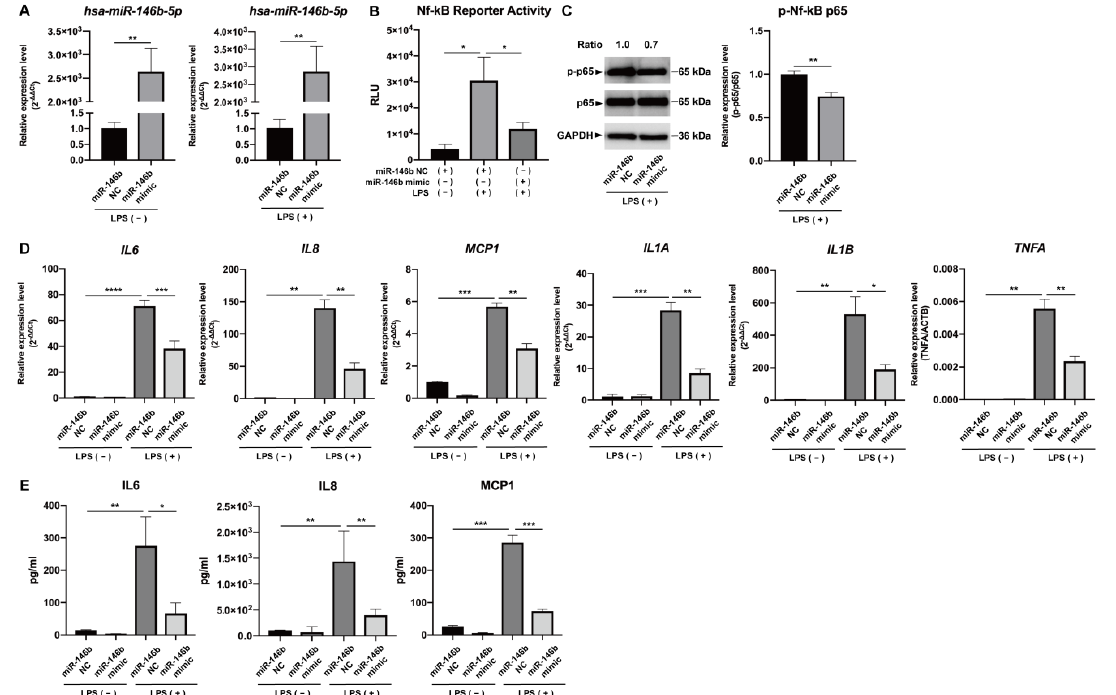
Figure 3. hsa-miR-146b-5p mimic down-regulates the activated NF-κB signaling and up-regulates expression of proinflammatory cytokines in LPS-stimulated hDPCs. ( A ) Transfection of hsa-miR- 146b-5p mimic induced up-regulation of hsa-miR-146b-5p in hDPCs with or without LPS stimulation (mean ± SD, n = 4). ( B ) hsa-miR-146b-5p mimic significantly down-regulated the promoted NF- κB reporter activity in hDPCs under 2 h LPS stimulation (mean ± SD, n = 4). ( C ) hsa-miR-146b-5p mimic significantly down-regulated the promoted phosphorylation of NF-κB p65 expression in hDPCs under 2 h LPS stimulation (mean ± SD, n = 4). ( D ) hsa-miR-146b-5p mimic significantly down-regulated the promoted mRNA expression of IL6 , IL8 , MCP1 , IL1A , IL1B , and TNFA in hDPCs under 2 h LPS stimulation (mean ± SD, n = 4). ( E ) hsa-miR-146b-5p mimic significantly down-regu- lated the promoted protein expression of IL6, IL8, and MCP1 in hDPCs under 2 h LPS stimulation (mean ± SD, n = 3). * p < 0.05, ** p < 0.01, *** p < 0.001, and **** p < 0.0001. LPS: lipopolysaccharide; hDPCs: human dental pulp cells; miR-146b NC: miRNA mimic Negative Control #1; miR-146b mimic: miRNA mimic for hsa-miR-146b-5p; RLU: relative light unit. 2.4. miR-146b-5p Targeted TRAF6, IRAK1, and RELA Tumor necrosis factor receptor-associated factor 6 (TRAF6), interleukin-1 receptor- associated kinase 1 (IRAK1), and REL-associated protein (RELA/NF-κB p65) are essential mediators of NF-κB signaling and are the predicted target genes of miR-146b-5p (Tar- getScanHuman). Over-expression of hsa-miR-146b-5p significantly down-regulated mRNA and protein expression of TRAF6, IRAK1, and RELA in LPS-stimulated hDPCs ( p < 0.05 to 0.001, Figure 4A,B,D,E,G,H). Similar down-regulated expression of TRAF6, IRAK1, and RELA in LPS-stimulated hDPCs was confirmed by immunocytological eval- uation (Figure 4C,F,I). In addition, mRNA and protein expression of TRAF6, IRAK1, and RELA was independent of the presence of LPS ( p > 0.05, Figures 4A,B,D,E,G,H and S2). Furthermore, over-expression of hsa-miR-146b-5p significantly down-regulated the lucif- erase activity in hDPCs transfected with a reporter vector containing hsa-miR-146b-5p target sequence in the RELA 3′-UTR ( p < 0.05, Figure 4J,K), whereas such phenomena were not observed in hDPCs transfected with a reporter vector containing mutated hsa-miR- 146b-5p target region in the RELA 3′-UTR ( p > 0.05, Figure 4J,K).